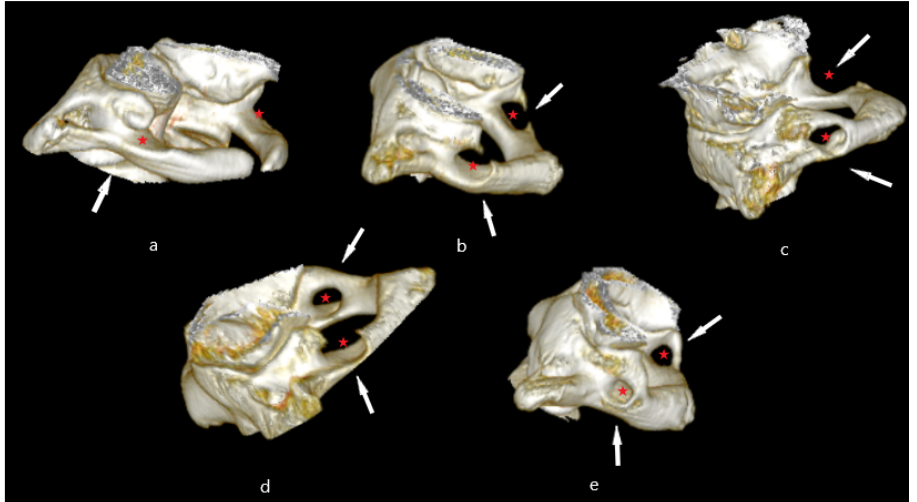
Figure 1. Ponticulus posticus morphologic features: ( a )—unilateral incomplete (Type I); ( b )—bilateral incomplete (Type II); ( c ),—unilateral complete right/left (Type III); ( d )—mixed (Type IV); ( e )—bilateral complete (Type V). Red star-the place where a bony bridge emerging from the posterior aspect of the superior articulating process, to connect the posterior arch of the atlas.